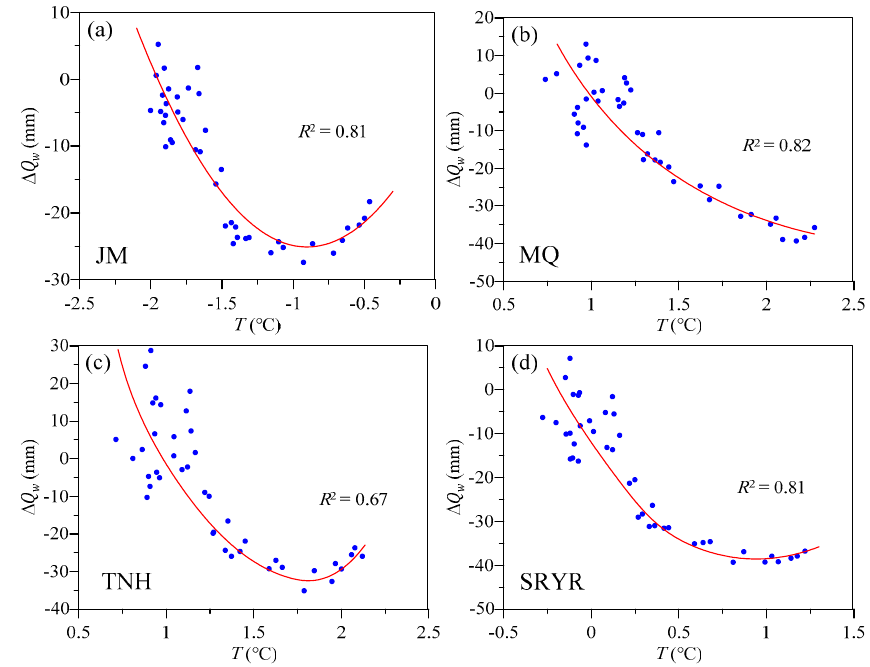
Figure 8. Relationship between temperature and Δ Q w in the three sub-basins and the source region of the Yellow River (SRYR).